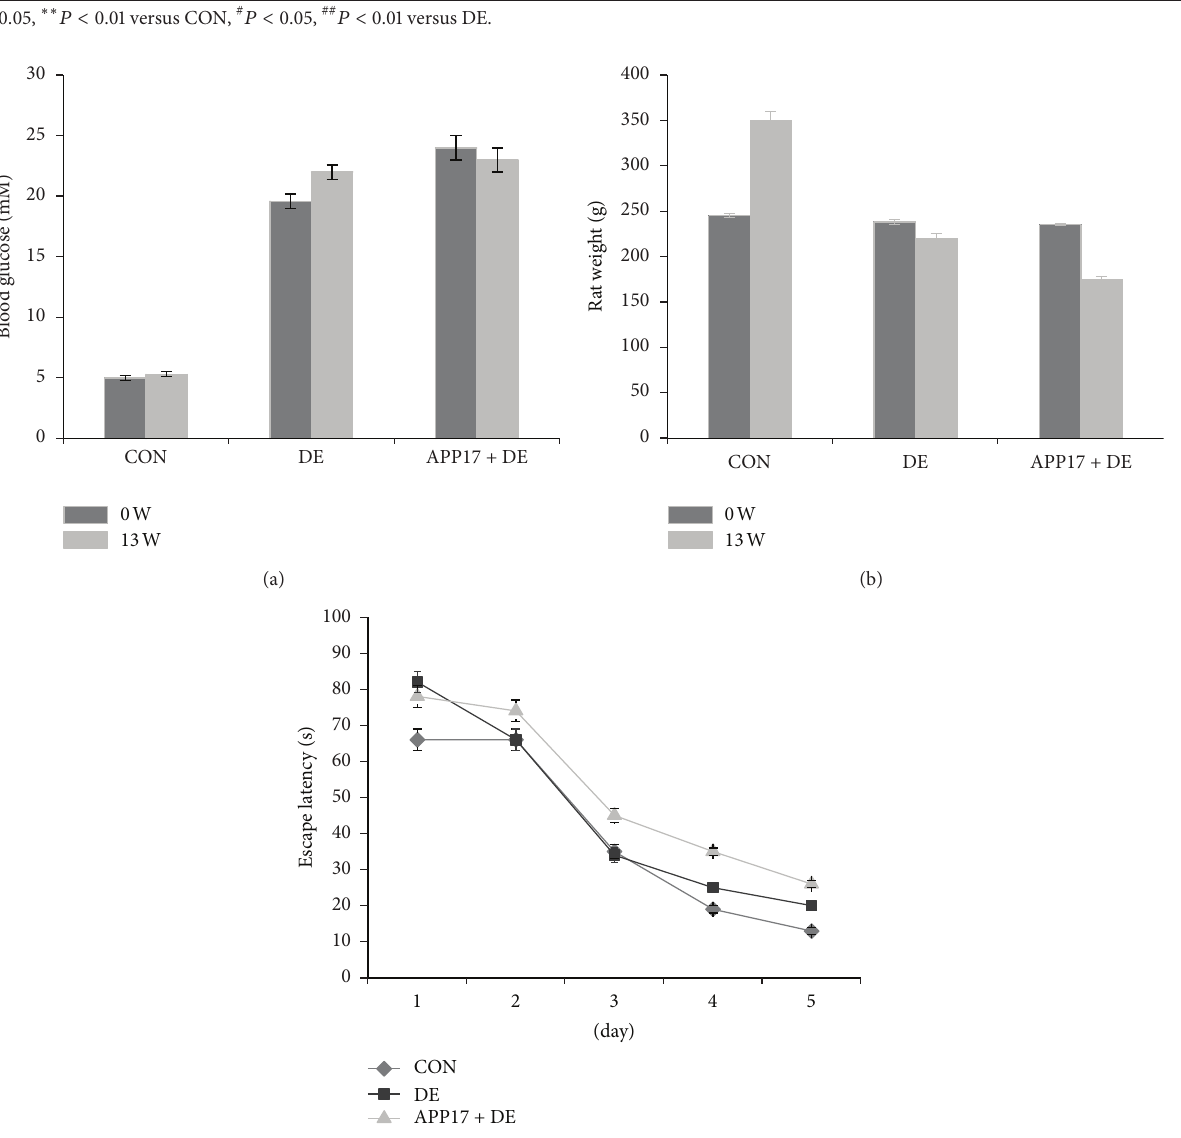
correlation was found between the DE group and DE + APP17 peptide group and the [ 18 F]-FDG uptake in the cortex and the hippocampus. Evaluation of glycol metabolism in animals revealed a decrease of cortical and hippocampal glucose uptake in the DE group compared with the CON group. In the DE + APP17 peptide group, the glucose uptake was increased, as compared with DE